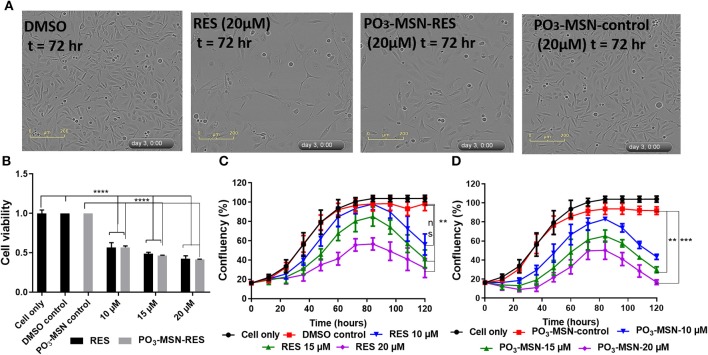
Resveratrol and PO3-MSN-RES inhibited proliferation and cell viability of PC3 cells. Cell proliferation and cell viability were measured using the InCucyte live system and CyQUANT, respectively. Data is presented as Mean ± SEM, n = 3, One-way ANOVA test, Tukey's post-hoc test, **P < 0.01, ***P < 0.001, **** P < 0.0001. (A) Representative phase contrast images of DMSO control, 20 μM of RES, 20 μM of PO3-MSN-RES and 20 μM of PO3-MSN-control treated PC3 cells are shown at 72 h. (B) RES and PO3-MSN-RES inhibited cell viability in a dose dependent manner (Each treatment normalized to vehicle i.e., DMSO and PO3-MSN-Control). (C) RES inhibited proliferation in PC3 cells (D) PO3-MSN-RES reduced proliferation.